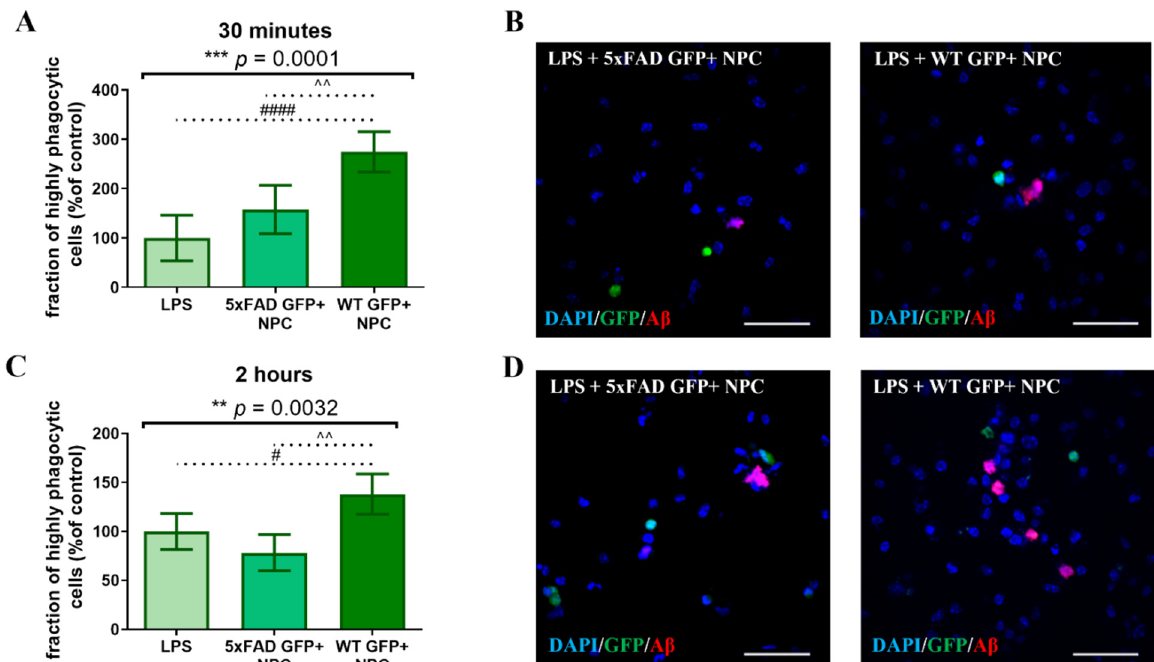
Figure 6. GFP+ NPCs extracted from SVZ of WT mice, but not 5xFAD mice, induced an increase in the fraction of microglia with high A β phagocytic activity. ( A ) Co-culturing of 5xFAD microglia with GFP+ NPCs extracted from WT mice showed an increased fraction of microglia with high A β phagocytic activity after 30 min. One-way ANOVA: *** p = 0.0001, post hoc analysis indicated that highly phagocytic microglia in the WT GFP+ NPCs group were increased compared to other conditions. WT GFP+ NPCs vs. 5xFAD GFP+ NPCs: ˆˆ p = 0.0081, WT GFP+ NPCs vs. LPS: #### p < 0.0001. The fraction of microglia with high A β phagocytic activity in LPS (control condition) served as 100%. ( B ) Representative images of microglia with high A β phagocytic activity after 30 min. ( C ) Co-culturing of 5xFAD microglia with GFP+ NPCs extracted from WT mice showed an increased fraction of microglia with high A β phagocytic activity after 2 h. One-way ANOVA: ** p = 0.0032, post hoc analysis indicated that highly phagocytic microglia in the WT GFP+ NPCs group were increased compared to other conditions. WT GFP+ NPCs vs. 5xFAD GFP+ NPCs: ˆˆ p = 0.0026, WT GFP+ NPCs vs. LPS: # p = 0.0256. The fraction of microglia with high A β phagocytic activity in LPS (control condition) served as 100%. ( D ) Representative images of microglia with high A β phagocytic activity after 2 h. Blue = DAPI, green = GFP, red = A β , scale = 50 µ